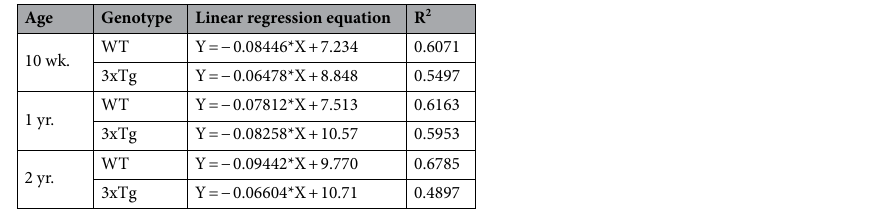
Table 1. Linear regression results for BBB closing